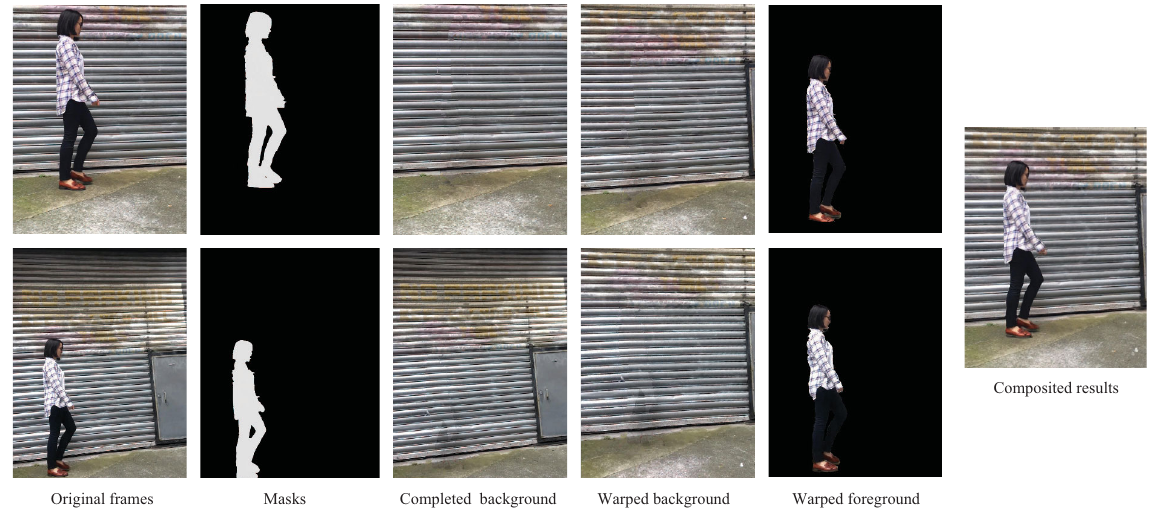
Fig. 6 Inputs and outputs of the foreground and background warping. The upper row and lower row are frames at the same time t from two